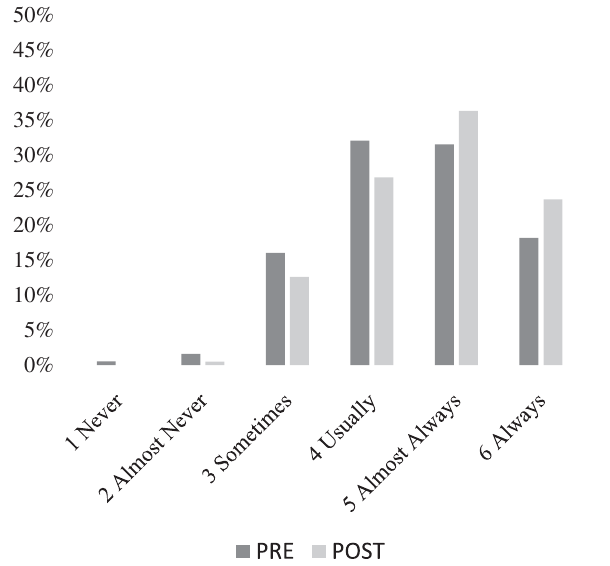
FIG. 3. The response distribution for the statement with the largest effect size (statement 3). Dark gray bars correspond to preinstruction responses and light gray bars correspond to post- instruction responses.